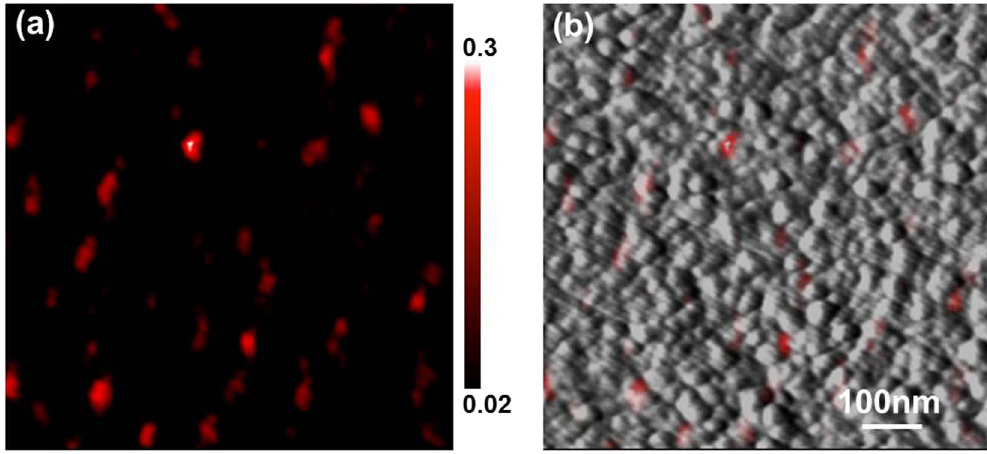
Figure 5. ( a ) SNOM-Raman mapping. ( b ) SNOM-Raman mapping overlaid on the corresponding topographic